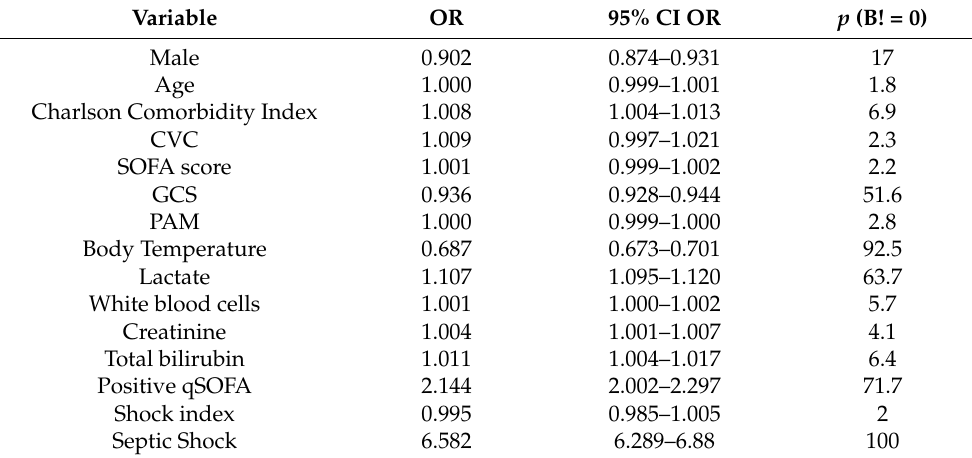
Figure 1. Model selected by BMA for in-hospital mortality in septic cases. Table 2. Bayesian mean of multivariate logistic regression performed to investigate the association with the in-hospital mortality outcome in septic cases.